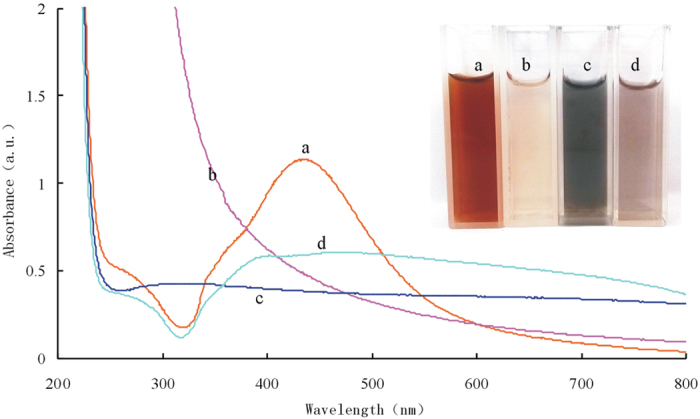
UV spectra of the AgNR-Hg(II) system(a) 4 × 10−4mol/L AgNR -0.3 mol/L HAc; (b) 4 × 10−4mol/L AgNR -0.3 mol/L HAc -0.1 mmol/L Hg(II); (c) 4 × 10−4mol/L AgNR -0.3 mol/L HAc -0.1 μmol/L Hg(II)-0.24 mol/L NH3.H2O; (d) 4 × 10−4mol/L AgNR -0.3 mol/L HAc-0.24 mol/L NH3.H2O.